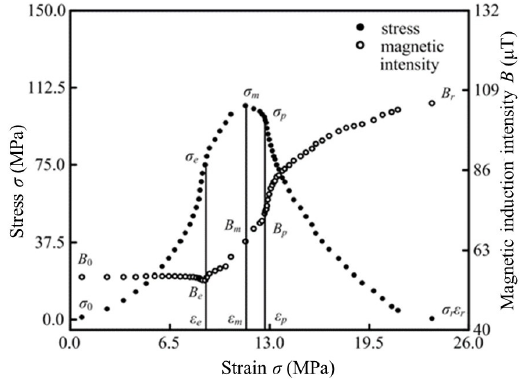
Figure 14. Results of Chen et al.’s research [17].